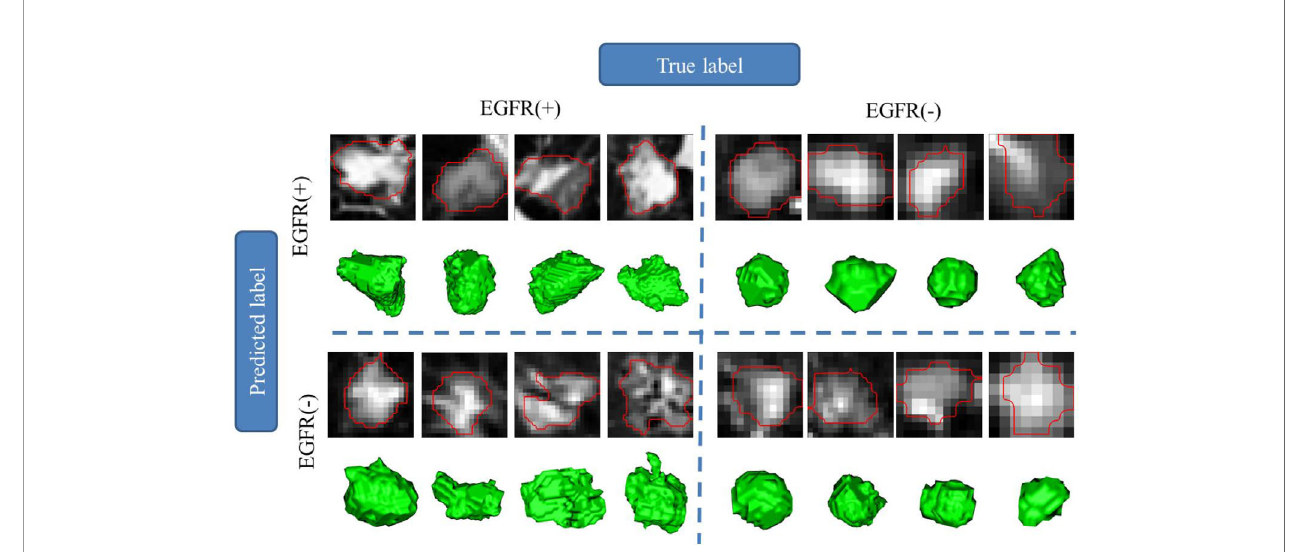
FIGURE 7 | Region of interest (lesion) and 3D visualization for different EGFR status prediction in